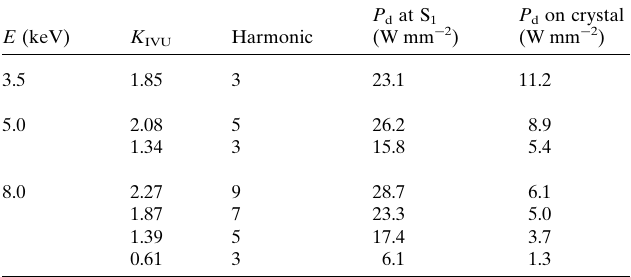
Table 1 Calculated average power density P d at S 1 and at the crystal surface for different values of photon energy and undulator deflection parameter K